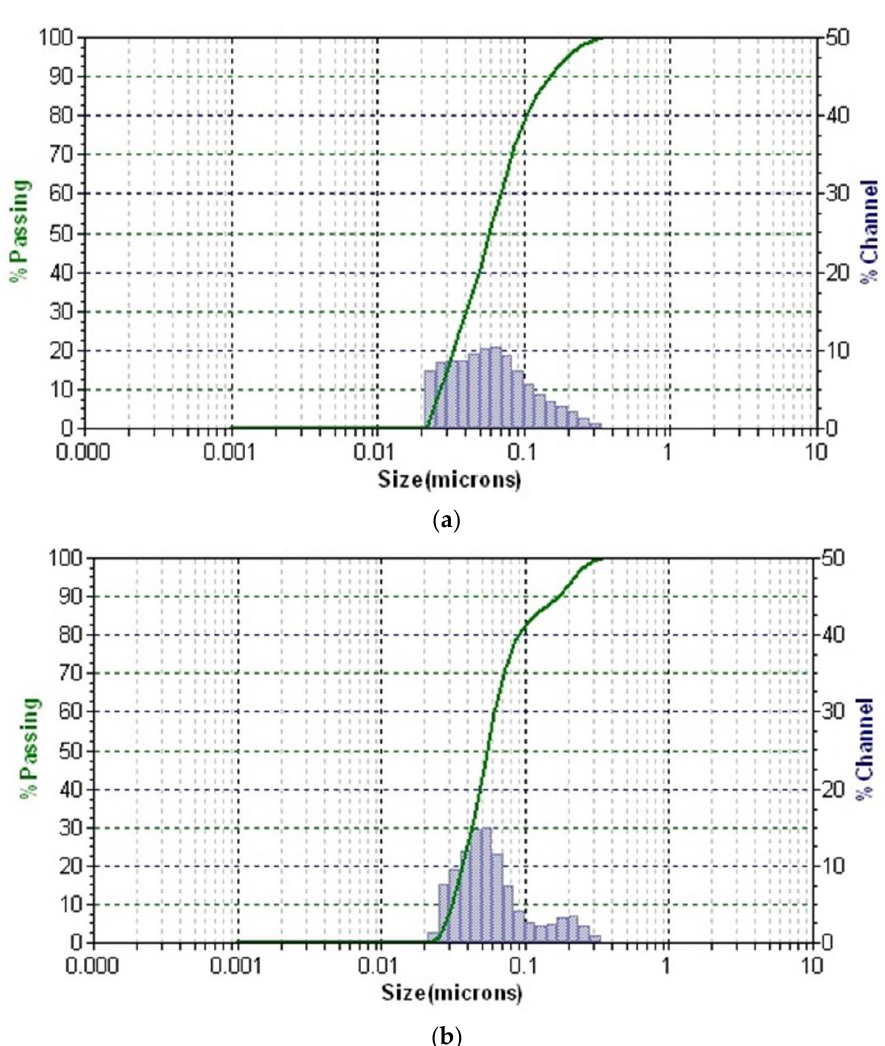
Figure 10. ( a ) DLS pattern of citrate-coated AgNPs. ( b ) DLS pattern of the phytocarrier system. The particles have a size of 100 nm, corroborating the UV-Vis and SEM results.